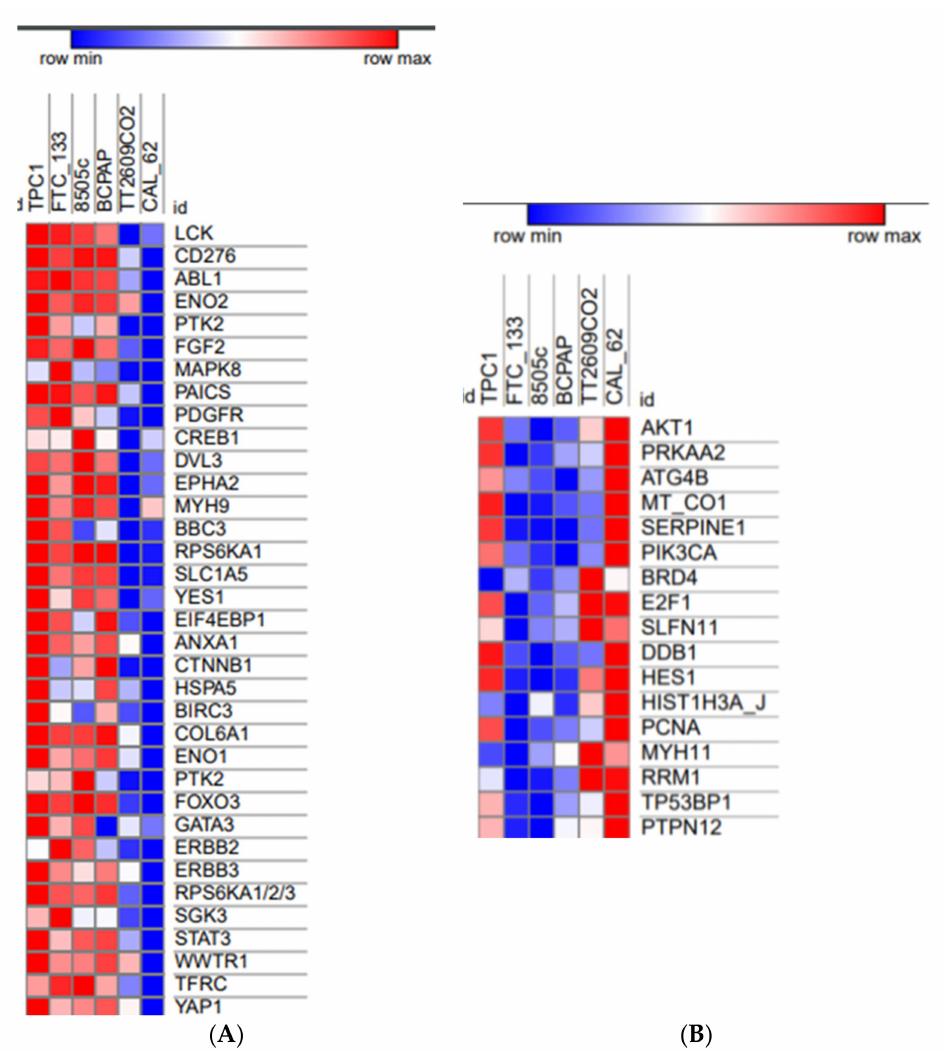
Figure 5. Heatmaps generated from RPPA data comparing thyroid cell lines based on OTX008 IC50 values for proliferation. ( A ) Subgroup of 35 up-regulated proteins and ( B ) subgroup of 17 down- regulated proteins in comparison to the protein profile in CAL 62 cells. Shades of red represent a high phosphorylation/expression profile in opposition to shades of blue corresponding to a weak phosphorylation/expression